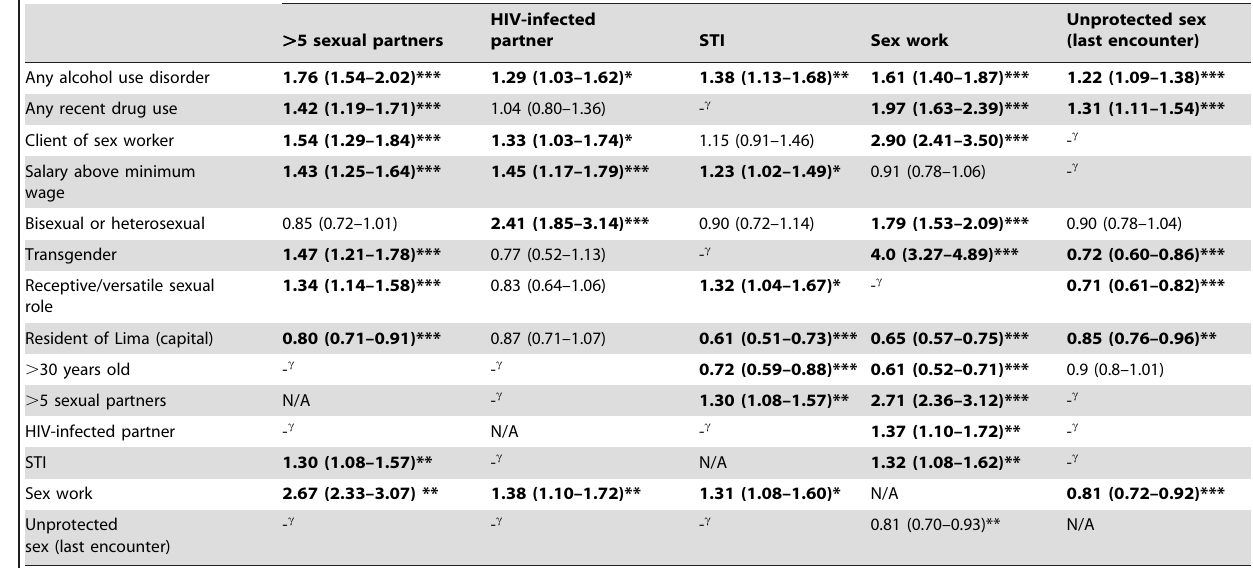
Covariates Adjusted Odd Ratios (95% Confidence Intervals) for dependent variables HIV-infected . 5 sexual partners partner STI Sex work